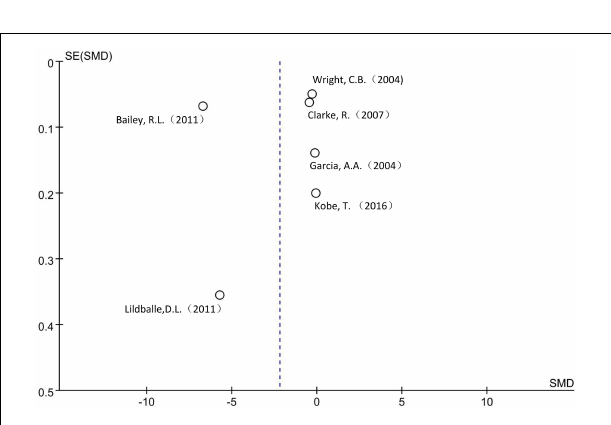
FIGURE 3 | Funnel plot of the six included cross-sectional studies.